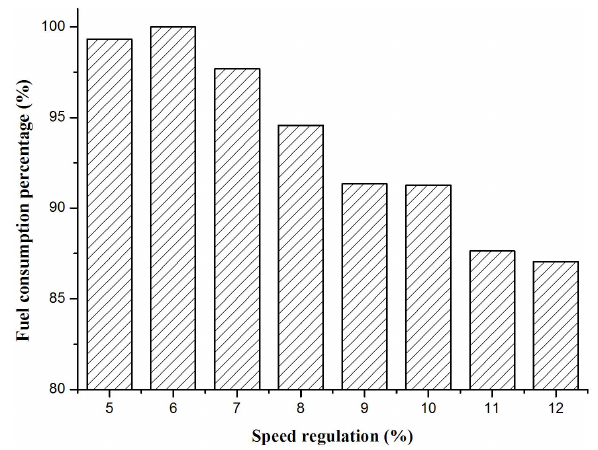
Figure 13. Fuel consumption percentage in the smooth driving cycle.